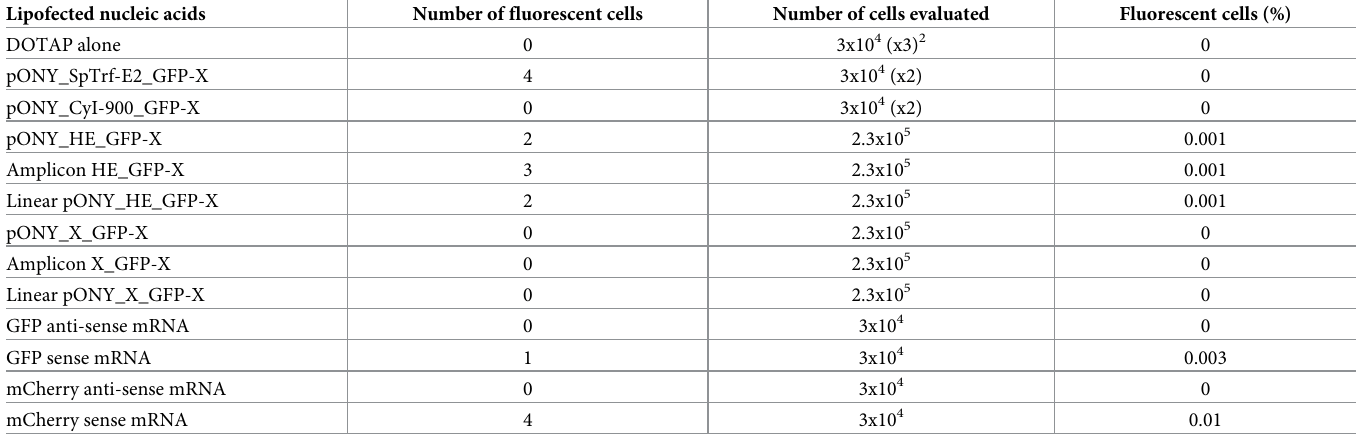
Table 4. Coelomocytes do not express GFP after transfection with expression constructs or with mRNA encoding fluorescent proteins. Lipofected nucleic